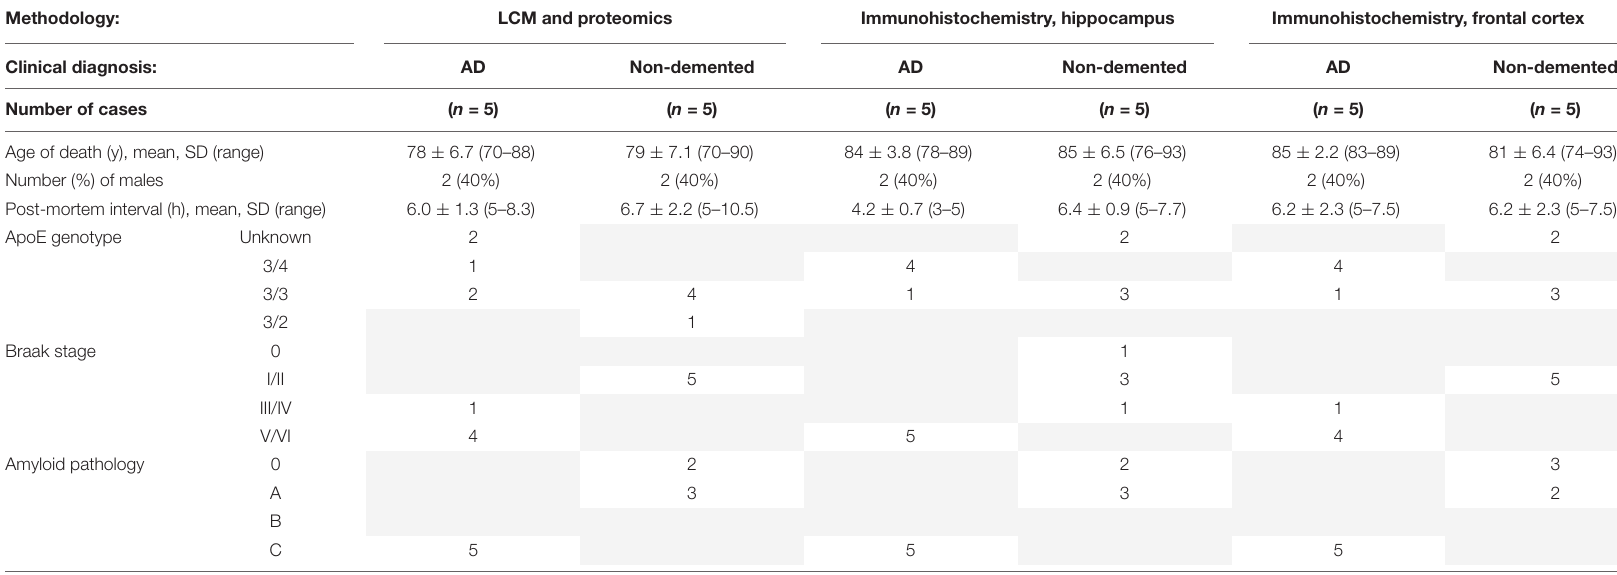
TABLE 1 | Demographics and clinical information of study subjects.